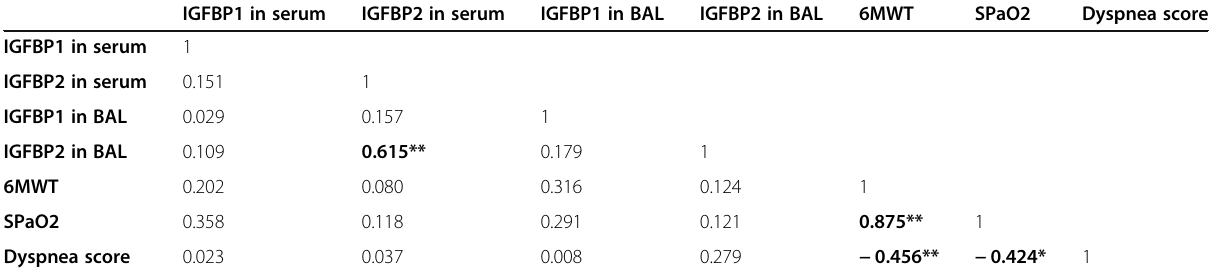
Table 5 Relation between some biomarkers and dyspnea score in UIP group after